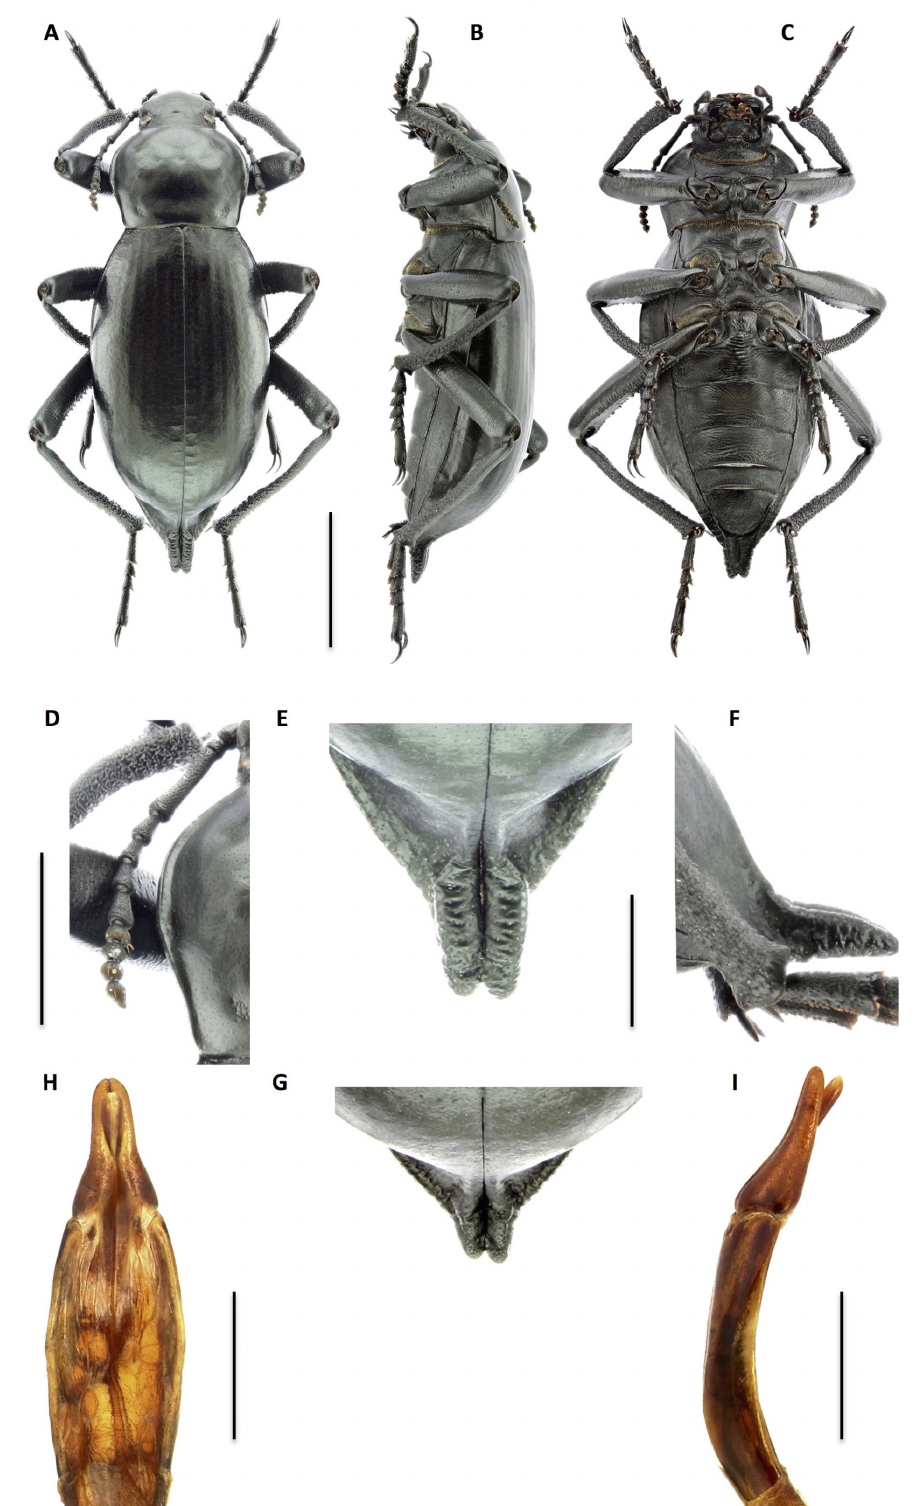
Fig. 5. Blaps teocchii Soldati sp. nov. A . ♂, habitus (dorsal view). B . ♂, habitus (lateral view). C . ♂, habitus (ventral view). D . ♂, left antenna (dorsal view). E . ♂, mucro (dorsal view). F . ♂, mucro (lateral view). G . ♀, mucro (dorsal view). H . ♂, aedeagus (ventral view). I . ♂, aedeagus (lateral view). Scale bars: A–C = 10 mm; D = 5 mm; E–G = 2 mm; H–I = 1.5